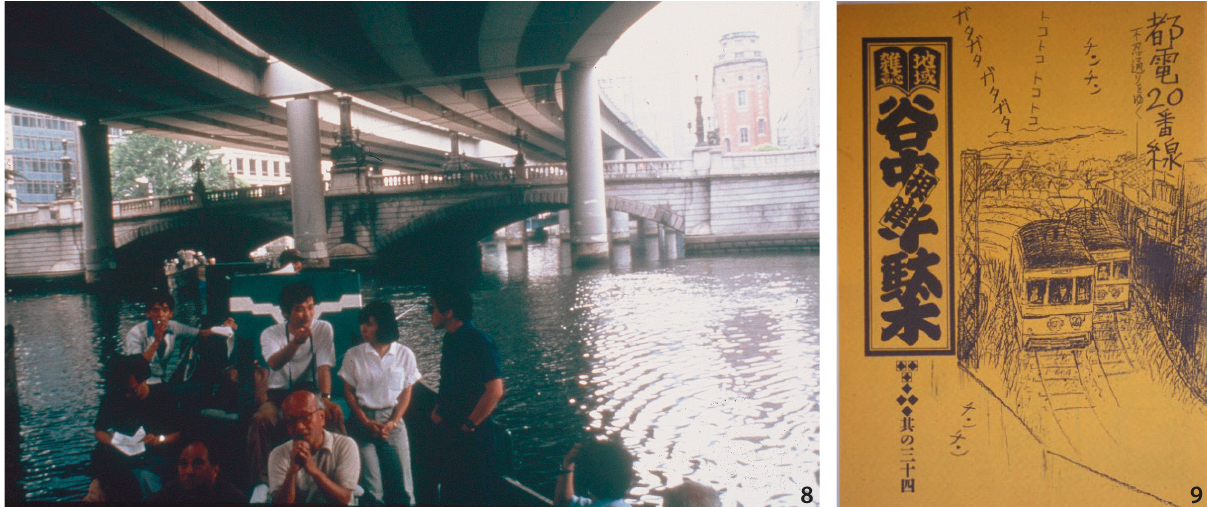
Figure 8 Survey of Tokyo water city, using a boat, by Jinnai Laboratory, begun in 1980 (Source: the author). Figure 9 Yanesen , a pioneering community magazine.